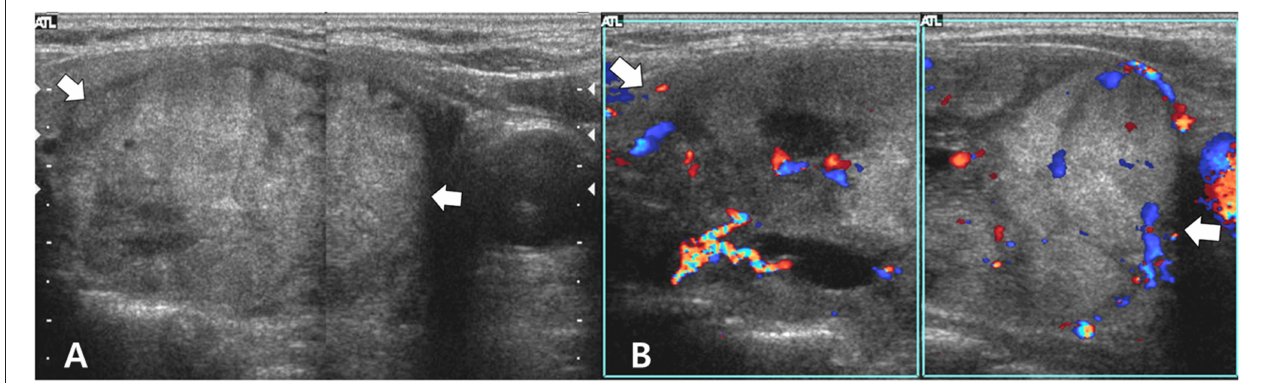
FIGURE 1 | Longitudinal gray-scale (A) and color Doppler (B) sonograms show a predominantly solid thyroid nodule (arrows, 5.5cm in the largest diameter) in the right lobe. This nodule exhibits benign sonographic features such as isoechogenicity, smooth margins, a hypoechoic halo, oval shape, and peripheral vascularity.